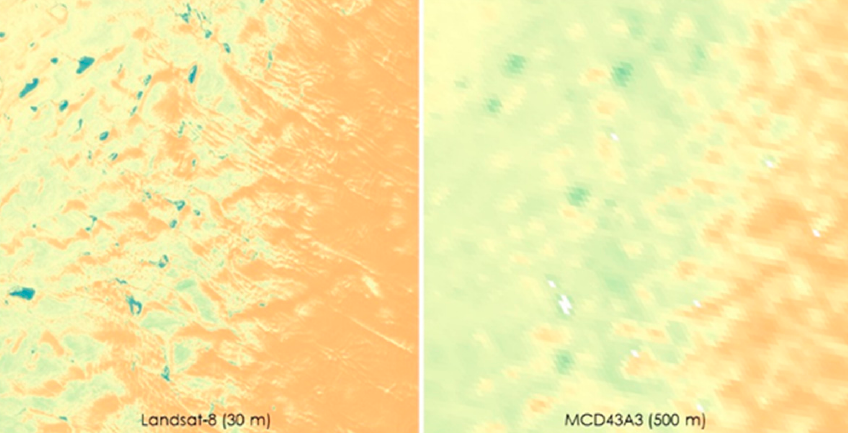
Figure 6. Comparison of the albedo pattern as measured by Landsat-8 ( left , 30 m resolution) and MODIS ( right , 500 m resolution) on 2019-06-10. Although the overall pattern is consistent between the two sensors, the increased spatial variability afforded by Landsat-8 provides considerably more detail.